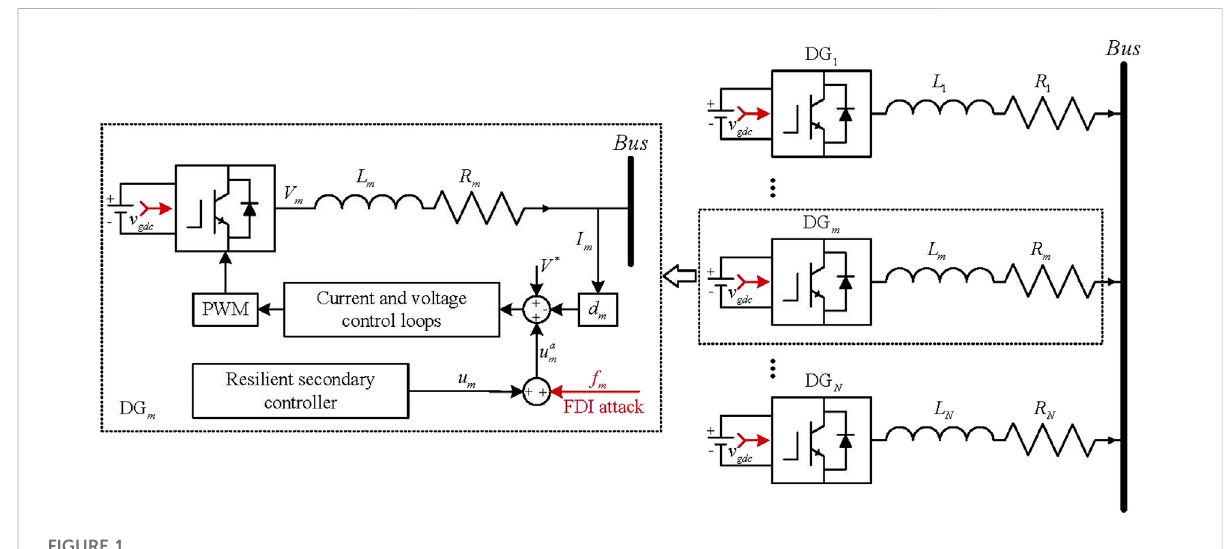
FIGURE 1 DC MG model under FDI